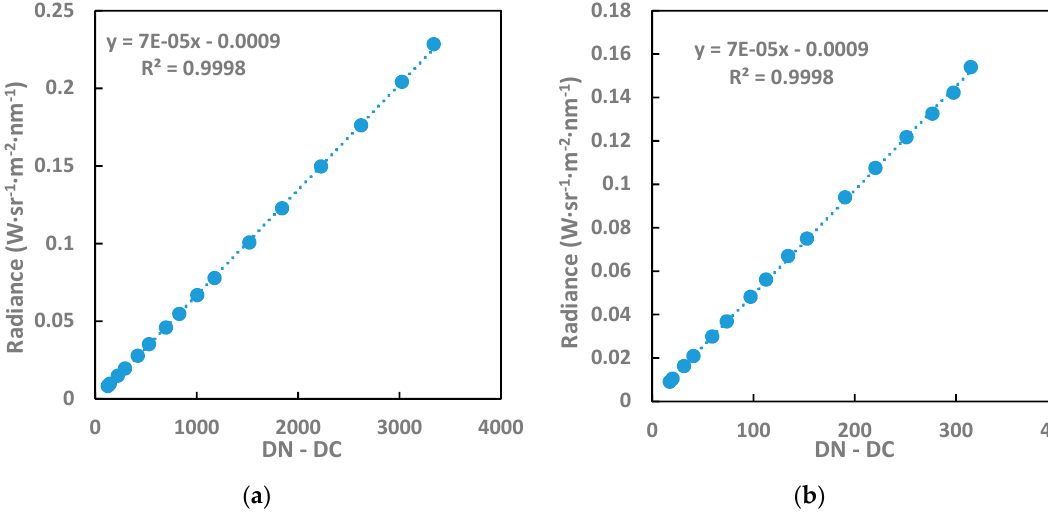
Figure 4. The linear regression between the (DN-DC) values and corresponding radiance measured by the optical integration system ( a ) for the band 650 nm and ( b ) for the band 946 nm.